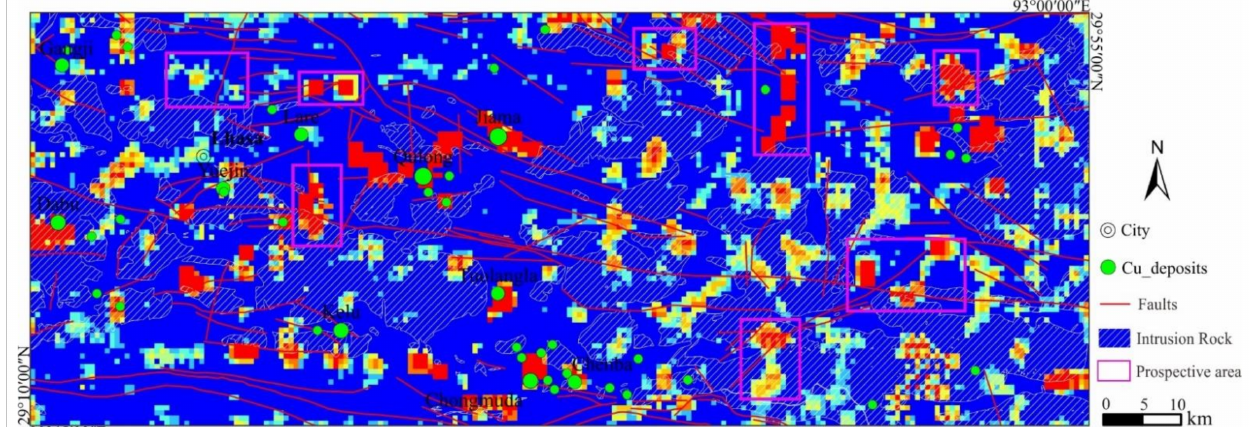
Figure 13. Prospective targets of mineral